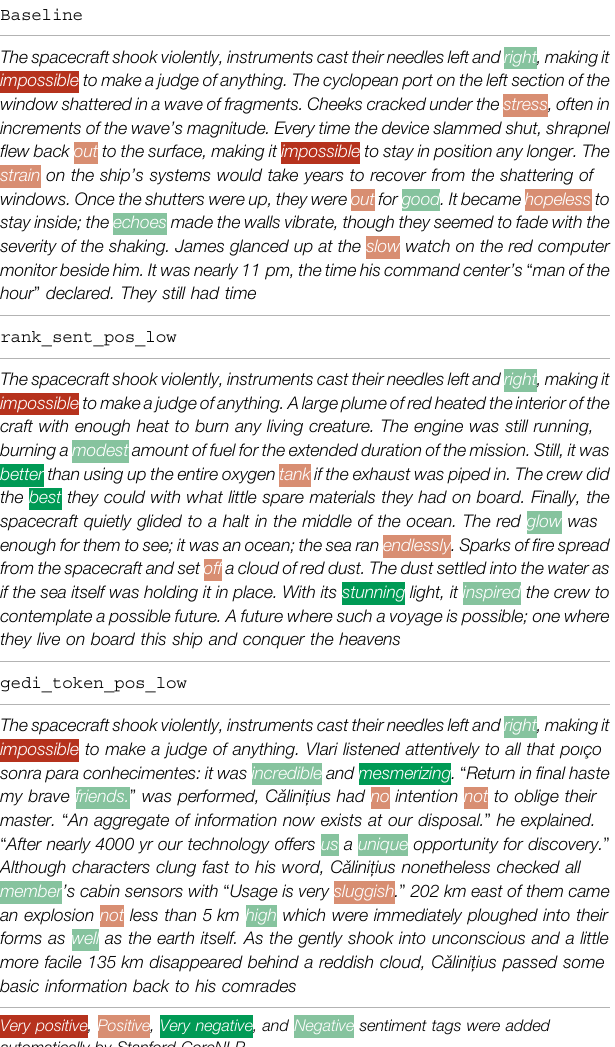
TABLE 12 | Example stories generated with low positive sentiment steering.